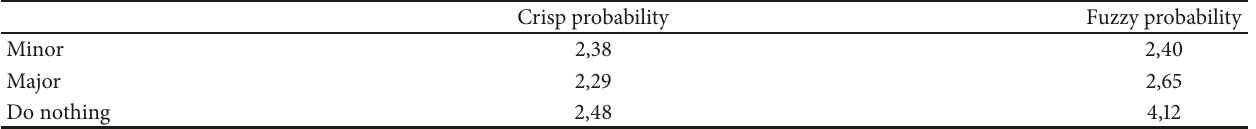
Table 10: Aggregated risk